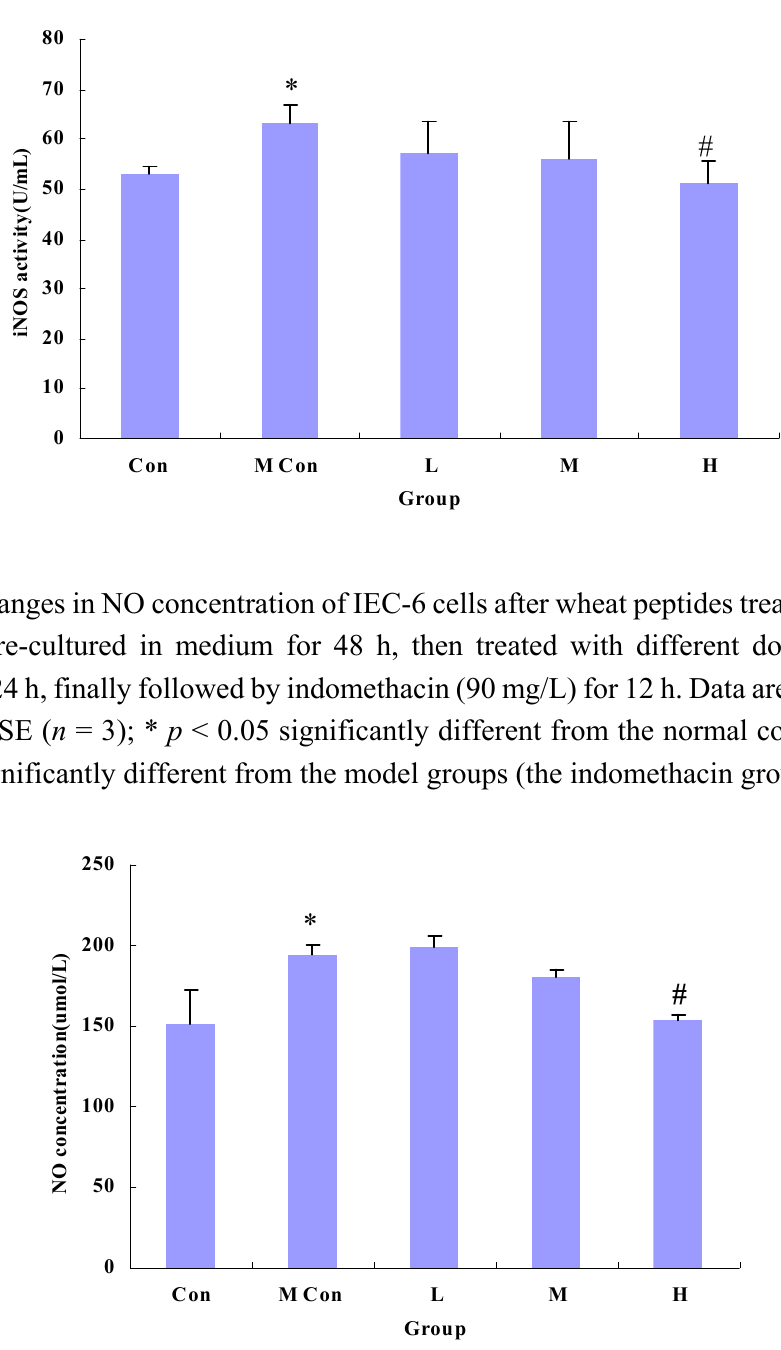
Figure 4. Changes in nitric oxide synthase (iNOS) activity of IEC-6 cells after wheat peptides treatment; IEC-6 cells were pre-cultured in medium for 48 h, then treated with different doses of wheat peptides for 24 h, finally followed by indomethacin (90 mg/L) for 12 h. Data are presented as the means ± SE ( n = 3); * p < 0.05 significantly different from the normal control groups; # p < 0.05 significantly different from the model groups (the indomethacin groups).